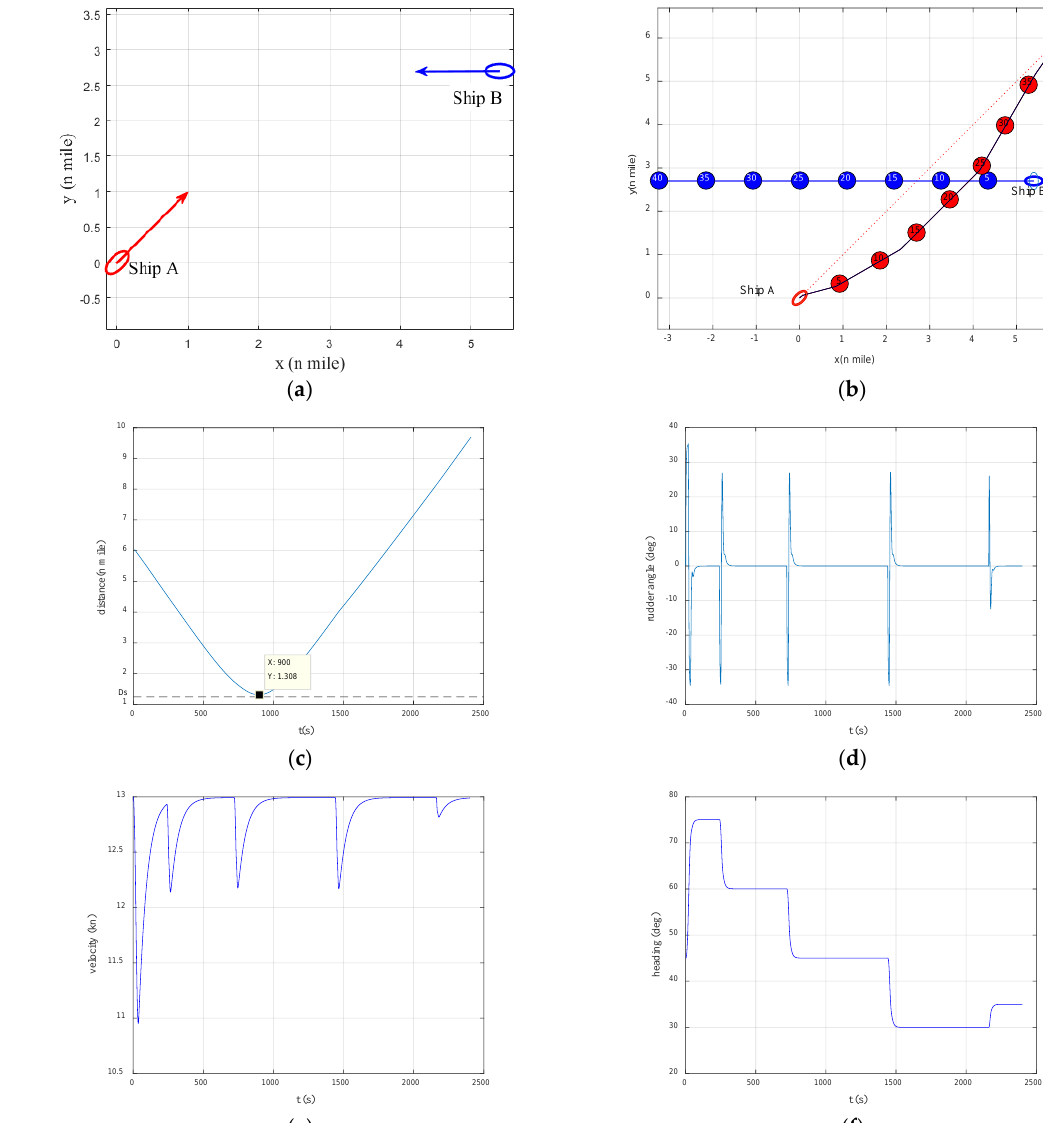
( f ) Figure 10. Simulation results for a head-on situation. ( a ) Initial traffic configuration; ( b ) optimal trajectory; ( c ) relative distance; ( d ) rudder angle of ship A; ( e ) velocity of ship A; and ( f ) heading of